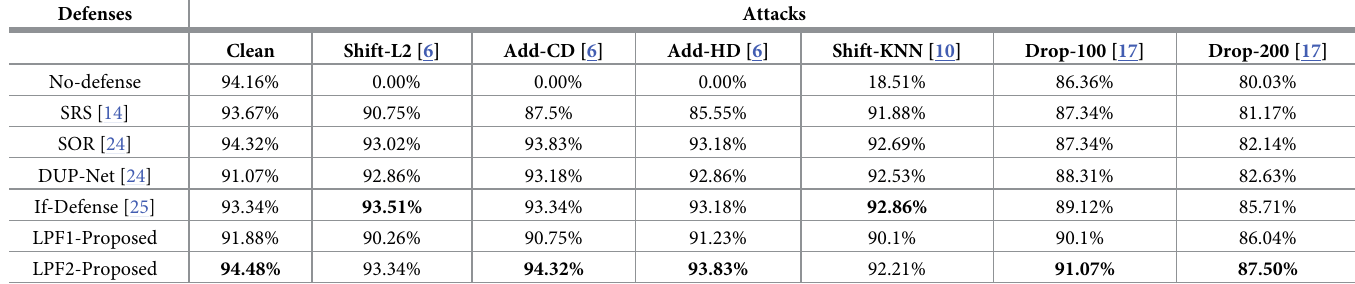
Table 5. Comparison of classification accuracy of proposed defenses with other defense strategies, under various attacks on PointNet and ShapeNet datasets. Defenses